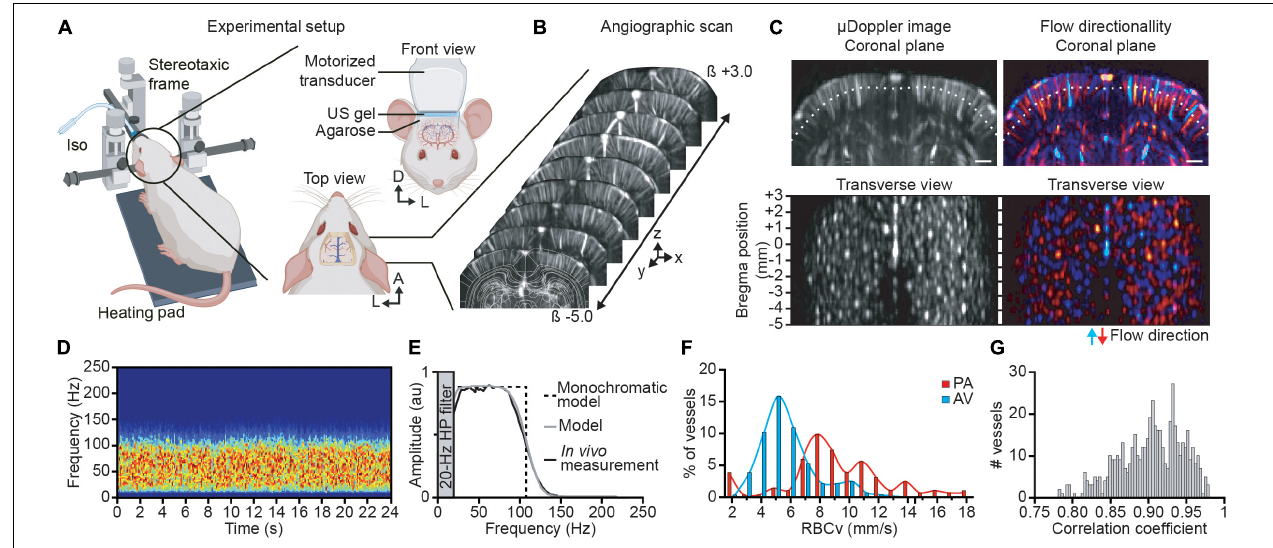
FIGURE 1 | Brain-wide angiographic scan and single vessel velocimetry. (A) Experimental set-up for brain-wide functional ultrasound imaging in isoflurane-anesthetized rats. (B) Antero-posterior cerebral µ Doppler images scan (i.e., angiographic scan) from bregma ( β ) +3 to − 5 mm overlaid with corresponding brain atlas plane (white outlines). X, y, and z are the axis convention of the µ Doppler image. (C) Original and color-coded coronal µ Doppler image (top). The red range of intensities depicts the positive part of the Doppler spectrum corresponding to the blood flowing down in penetrating arteries, while the negative part of the Doppler spectrum, i.e., blood flowing up in ascending venules, is colored in the blue range. The white dotted line represents the section used for the transverse view representation located 0.5-mm deep down the cortical surface. Each spot corresponds to a sectioned cortical vessel before (left) and after directionality discrimination (right). (D) Spectrogram of a single cortical vessel showing a broadband and uniform signal in a control trial (no forepaw stimulation delivered). (E) Average spectrum of the vessel (black curve) showing a flat spectrum band from 25 to 80 Hz, monochromatic model (black dotted line) representing a simple square function, and the broadband model (gray curve) considering the 20-Hz high-pass filter and the transducer bandwidth model correctly fits the experimental data. (F) Distribution of the red blood cell velocity (RBCv) in cortical penetrating arterioles (PA; in red) and ascending venules (AV; in blue). (G) Correlation coefficient between the broadband model spectrum and the experimental data of all cortical vessels. A, anterior; D, dorsal; L, left. Scale bar = 1 mm. Created with